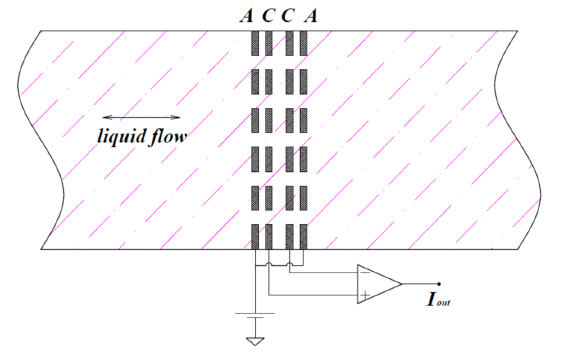
Figure 1. Schematic diagram of the electrochemical transducer. Anode/cathode/cathode/anode (ACCA) represents the